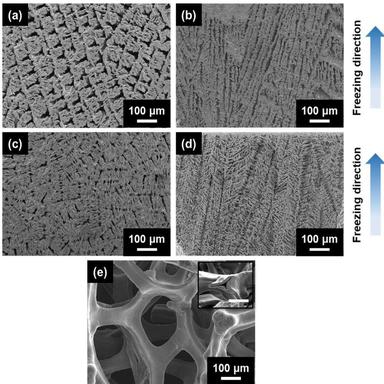
SEM images of (a, c) perpendicular and (b, d) parallel to freezing direction of Ni foam with varying oxide slurry fraction: (a–b) 5 vol% (V5) and (c–d) 7 vol% (V7), and (e) commercially available Ni foam. Inset in (e) shows the cross-section of a strut, scale bar is 100 μm.